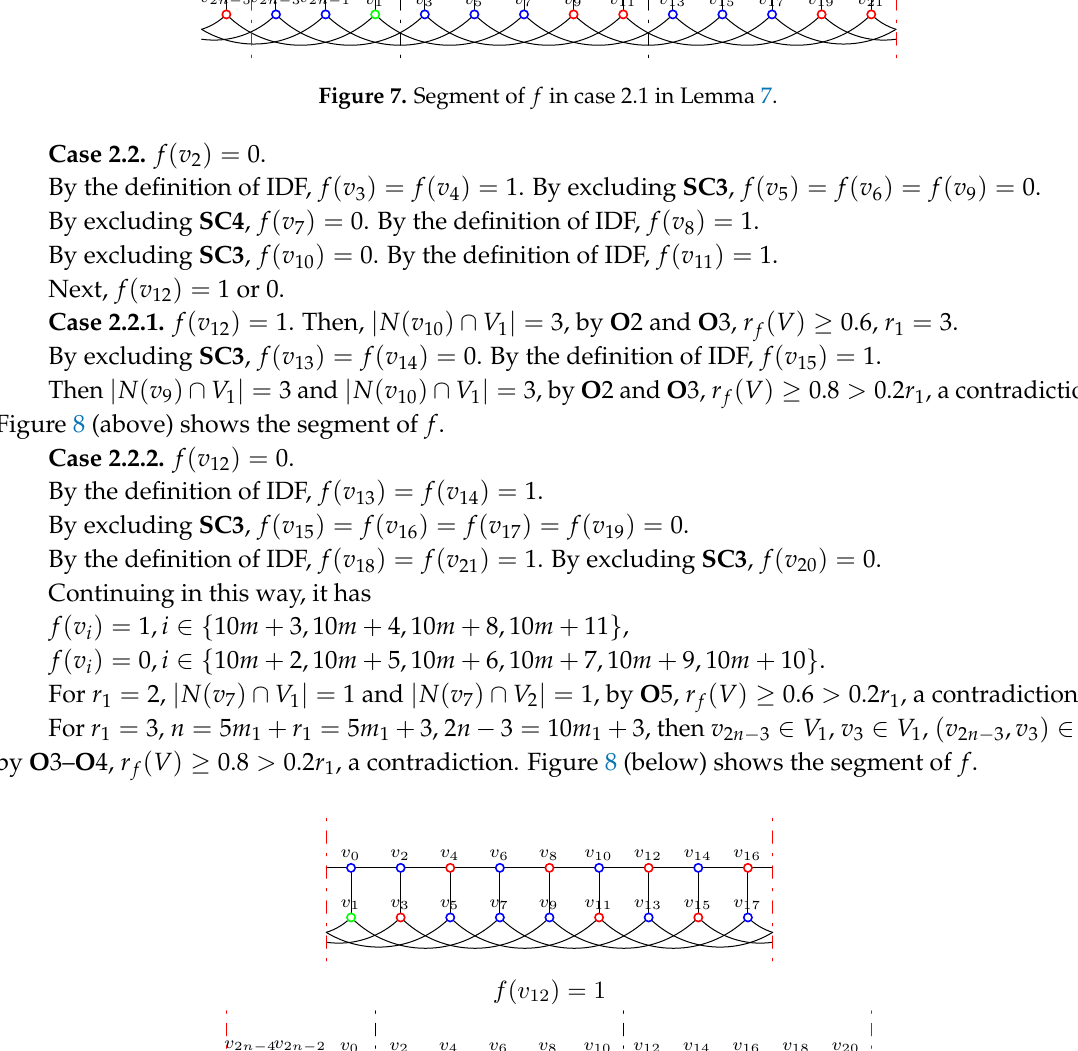
Figure 8. Segments of f in Case 2.2 in Lemma 7.